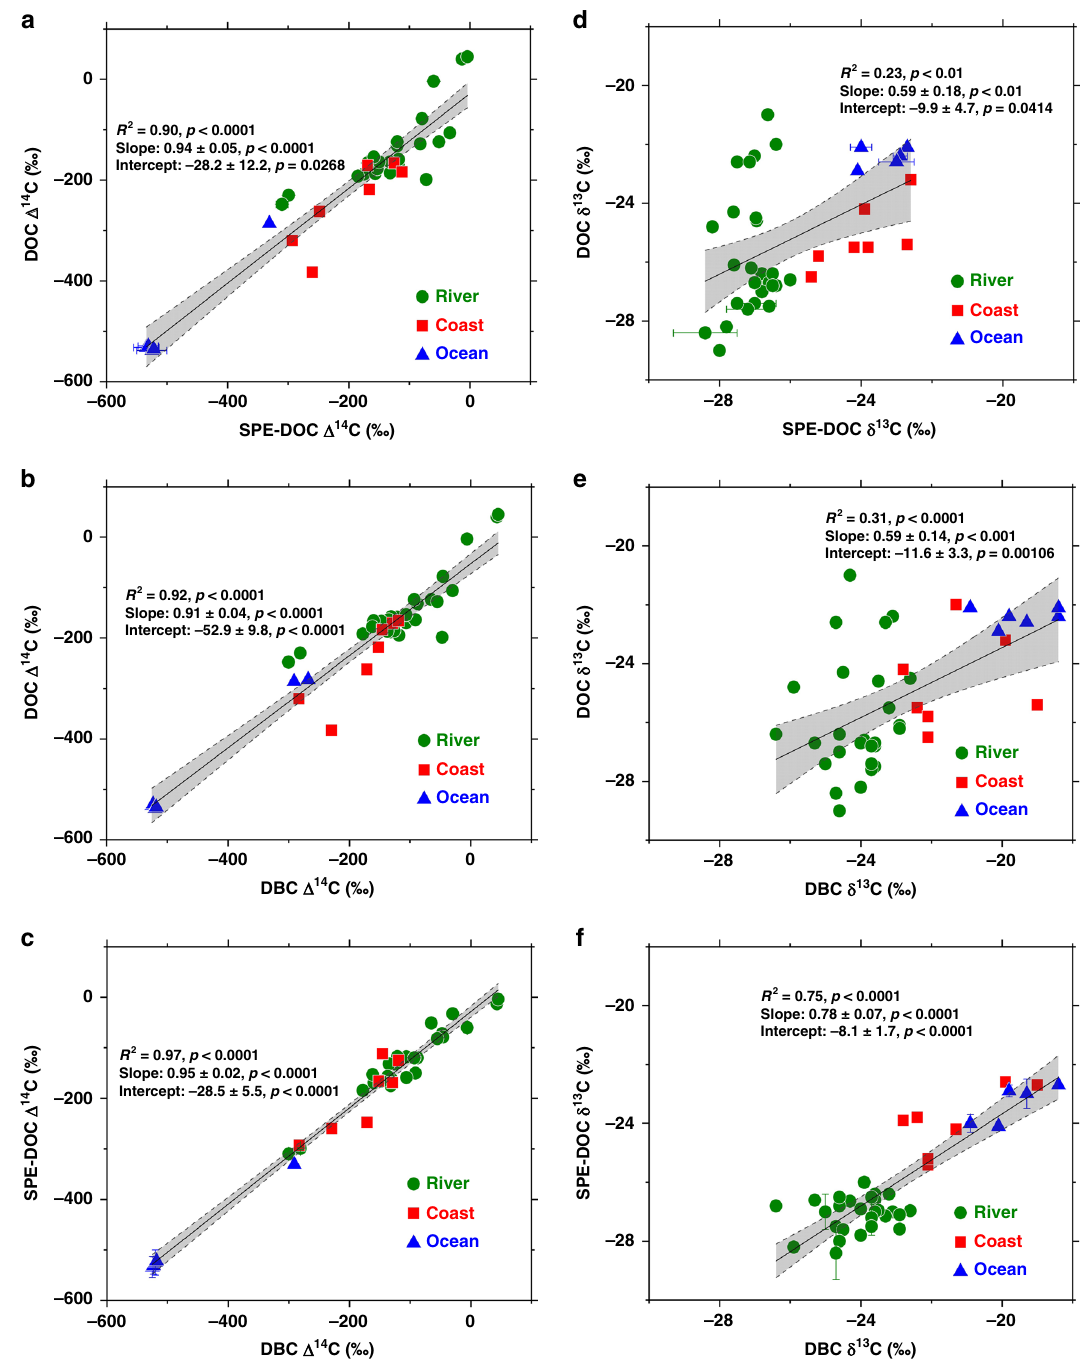
Fig. 4 Isotopic correlations between different carbon pools. a DOC Δ 14 C vs. SPE-DOC Δ 14 C ( n = 38), b DOC Δ 14 C vs. DBC Δ 14 C ( n = 40), c SPE-DOC Δ 14 C vs. DBC Δ 14 C ( n = 38); and d DOC δ 13 C vs. SPE-DOC δ 13 C ( n = 39), e DOC δ 13 C vs. DBC δ 13 C ( n = 40), and f SPE-DOC δ 13 C vs. DBC δ 13 C ( n = 39) for the river, coastal and ocean samples (DOC dissolved organic carbon, SPE-DOC solid phase extracted dissolved organic carbon, DBC dissolved black carbon). The points with error bars are the average values of duplicate measurements and the error bars represent the range of the measured values. The statistics are for the regression of all data points. The gray areas show the 95% con fi dence interval of the linear regression. We applied one-sided F test and two-sided t test, and the calculated p values as